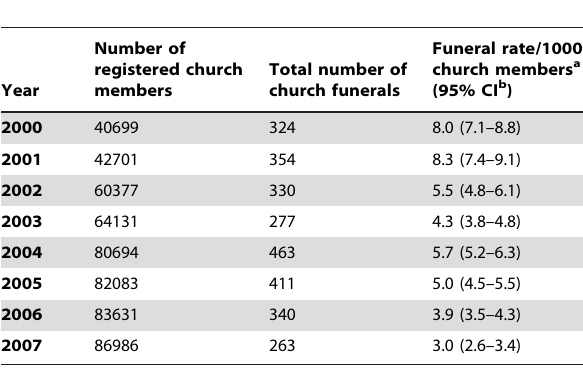
Table 4. Registered church funerals in the 5 traditional authorities (2000–2007), Thyolo district,